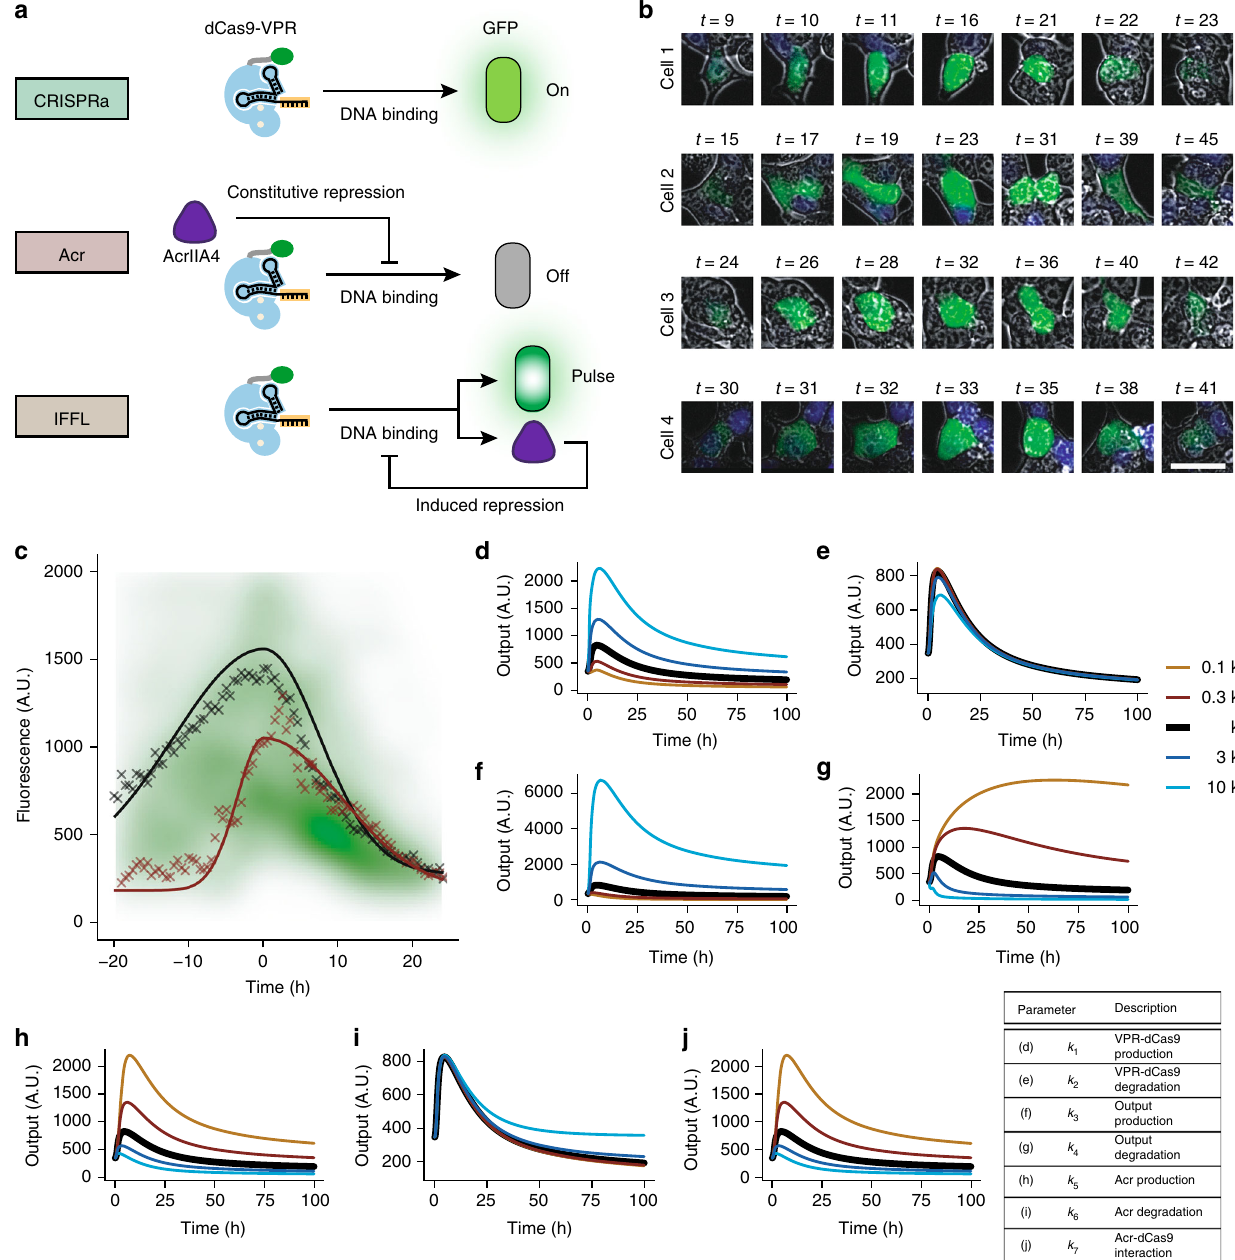
Fig. 6 Pre-programmed Acr-based genetic circuits. a Genetic circuits analyzed via live-cell microscopy. CRISPRa: dCas9-VPR drives inducible GFP reporter expression; Acr: constitutive expression of AcrIIA4 prevents dCas9-VPR-based CRISPRa activity; IFFL: dCas9-VPR simultaneously drives inducible GFP and AcrIIA4 expression, resulting in a pulse of activity. b Selected snapshots of cell-tracking traces of the IFFL circuit. Each row corresponds to a single trace, with time post-transfection annotated above each frame. Scale bar in lower right corresponds to 30 µ m. c – j Experimental and computational exploration of IFFL circuit activity. Circuit activity ( y -axis) corresponds to GFP production in c and computed response for an arbitrary circuit output for d – j . c Aligned activity of IFFL condition. Shown are the time-dependent median expression of GFP of cell tracking traces for two separate experiments (black and red points). Overlaid are median fi ts (solid lines) and the combined density plots of both experiments (green), encompassing n = 187 cell traces. t = 0 corresponds to aligned maximum of pulse for each trace. Source Data are provided as a Source Data fi le. d – j Parameter sensitivity analysis from computational modeling. Plotted are predictions of behavior of the IFFL circuit when changing d dCas9-VPR production rate; e dCas9-VPR degradation rate; f dCas9-VPR-dependent output production rate; g output degradation rate; h dCas9-VPR-dependent Acr production rate; i Acr degradation rate; j dCas9- Acr interaction rate. The thick black line for each plot corresponds to computed activity for the value of that parameter derived from fi ts to experimental data, while other lines correspond to alterations to that parameter plus or minus one order of magnitude. t = 0 corresponds to activation of circuit